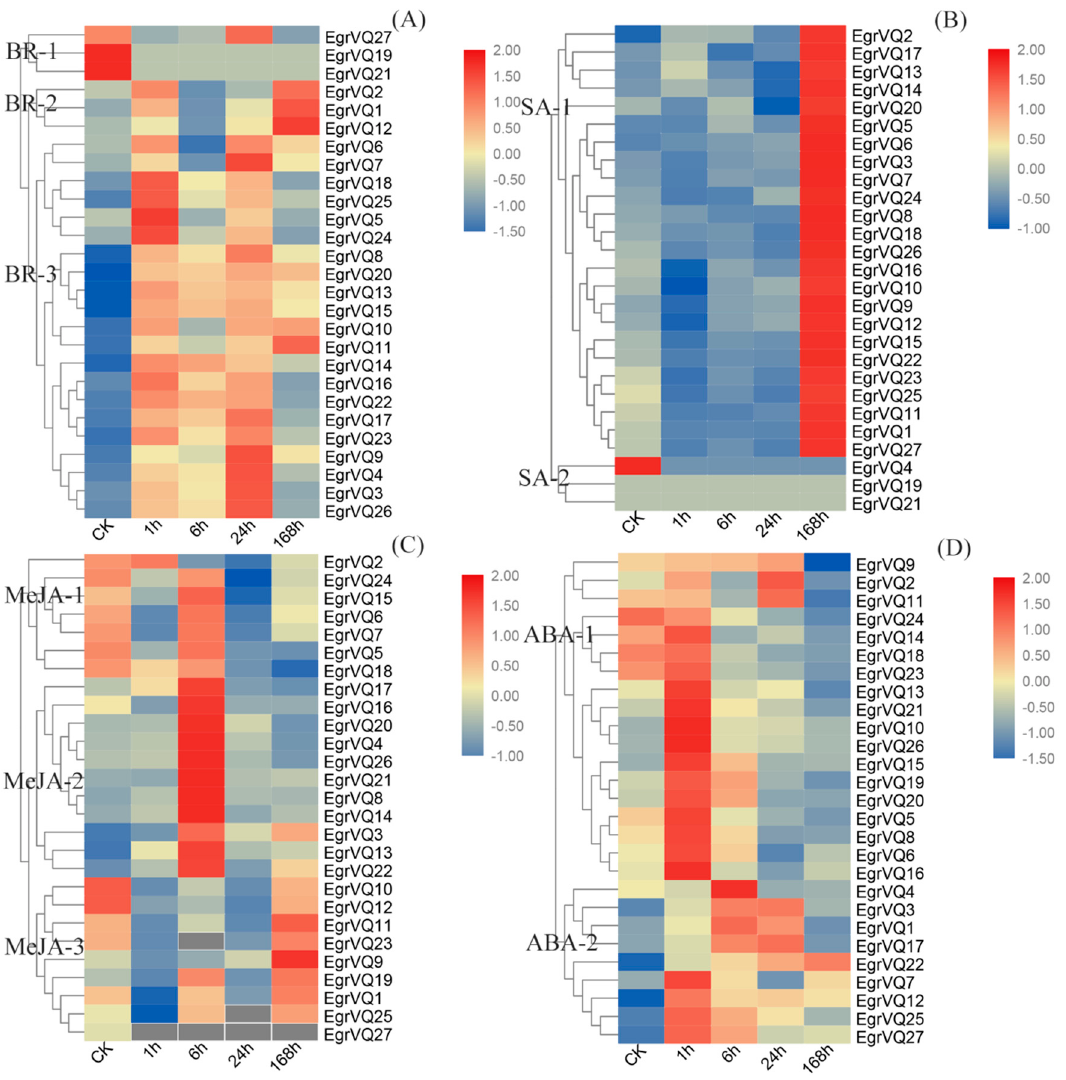
Figure 7. Expression analysis of 25 EgrVQ genes in E. grandis following brassinosteroid (BR) ( A ), salicylic acid (SA) ( B ), methyl jasmonate (MeJA) ( C ), and abscisic acid (ABA) ( D ) treatment, as determined by Real-Time quantitative PCR (qRT-PCR). The relative expression levels were calculated using the 2 − ∆∆ Ct method. The heatmap was created using MEV.